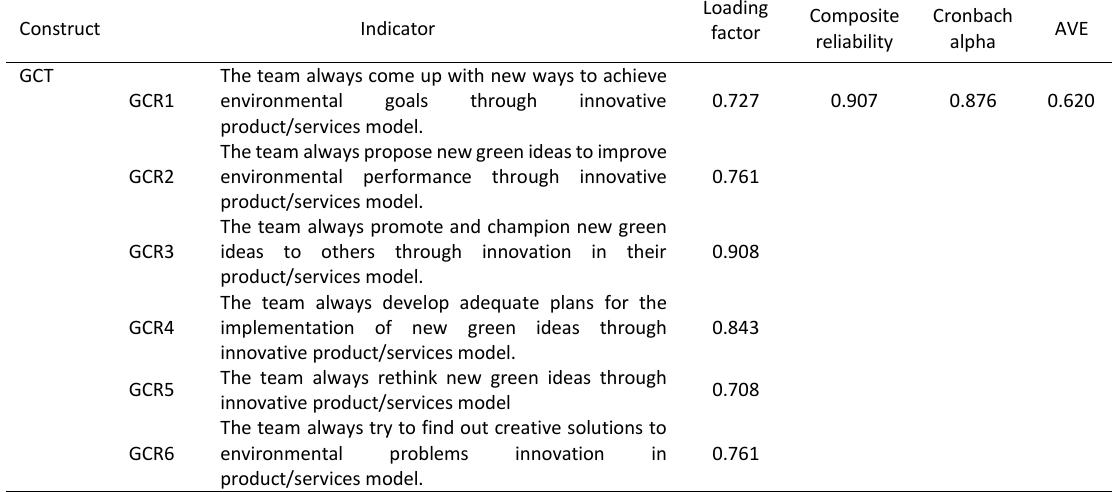
Table 3: Discriminant validity